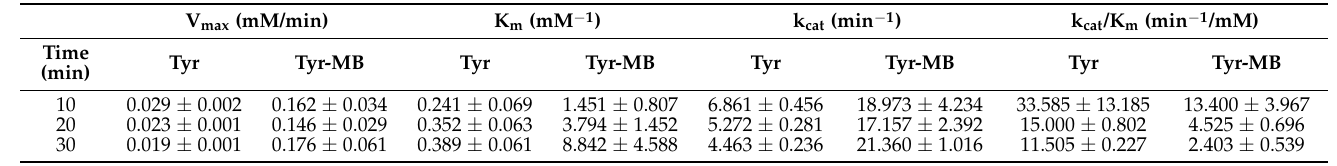
Table 1. Michaelis–Menten kinetic parameters of diphenol oxidase reaction.